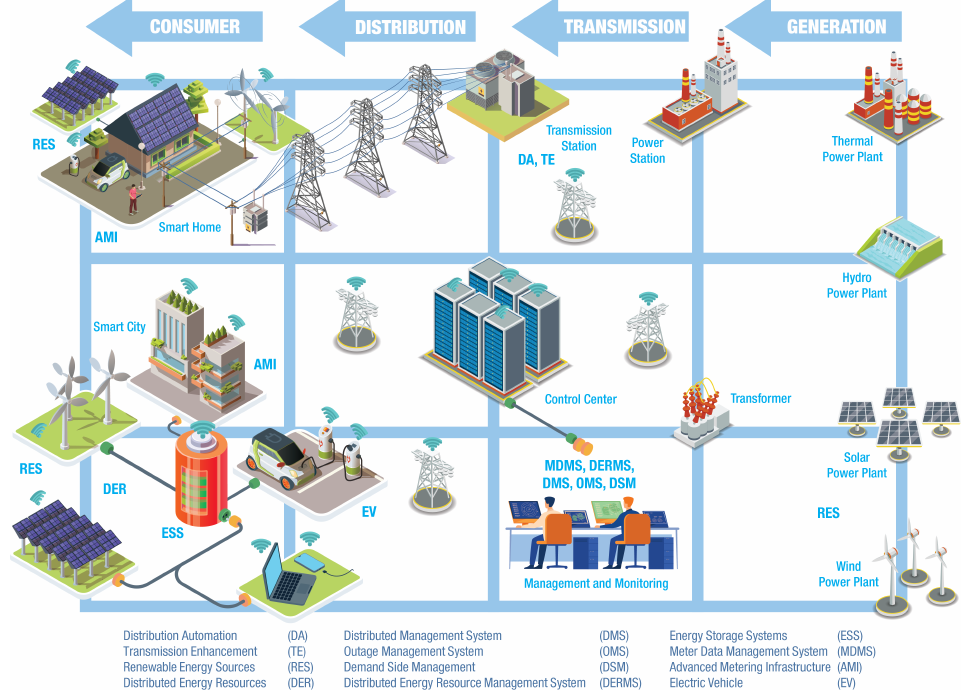
Figure 3. The overall architecture of the smart power management